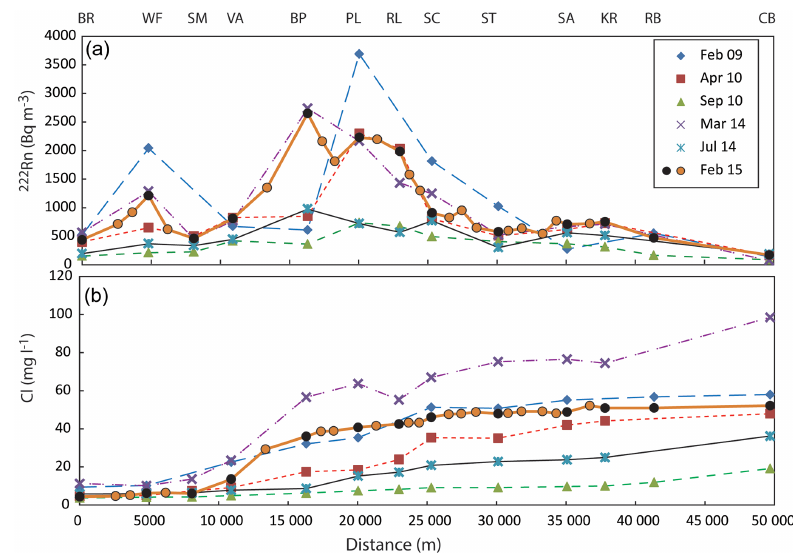
Figure 4. Downstream variations in 222 Rn activities (a) and Cl concentrations (b) for the six sampling campaigns (data from Table A1, abbreviations are as for Fig. 2). Closed symbols for February 2015 are from the main sites, open symbols are from the additional sites specific to that sampling campaign (Table A1). Site abbreviations are as for Fig.